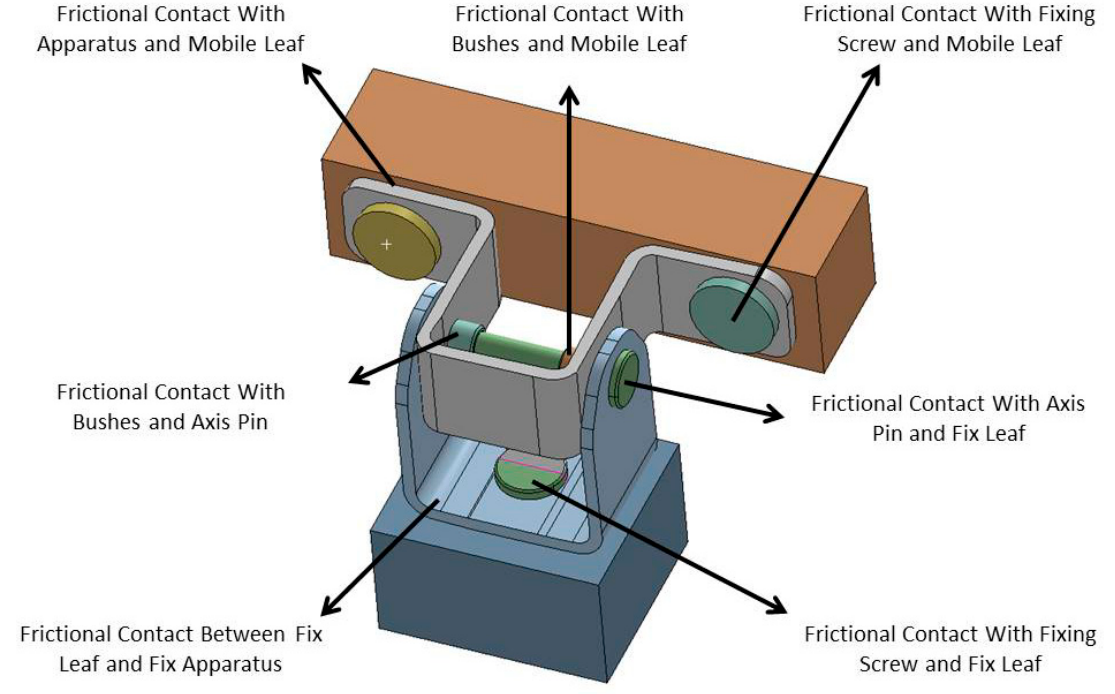
Figure 15. Contact definitions at the FE model.